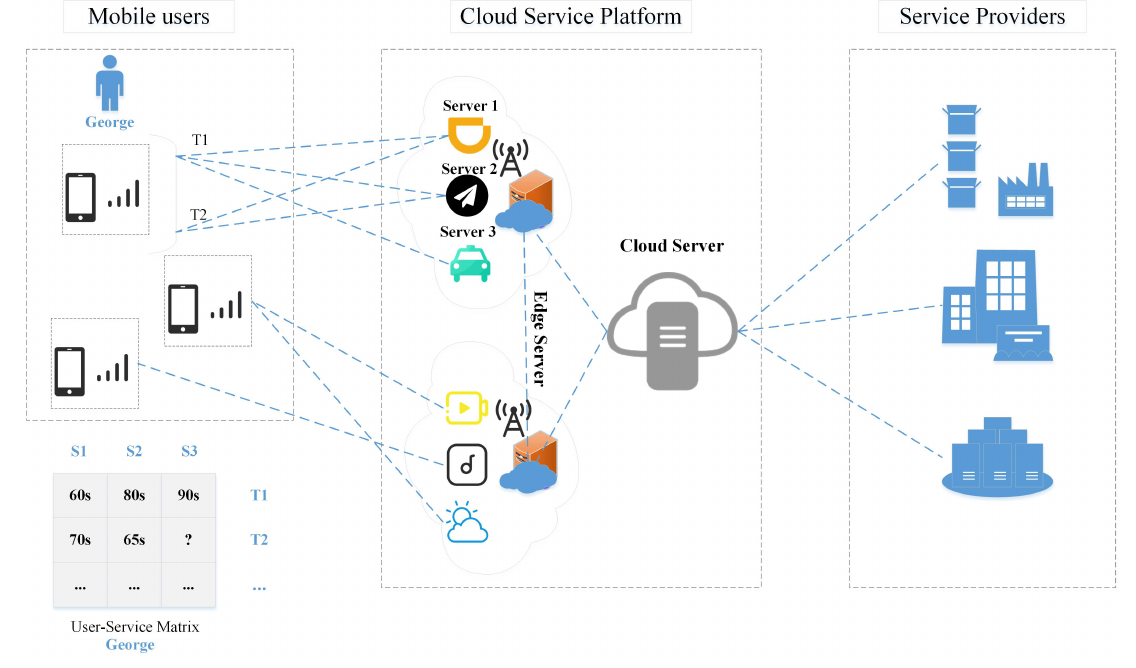
Figure 1. The MEC service invocation